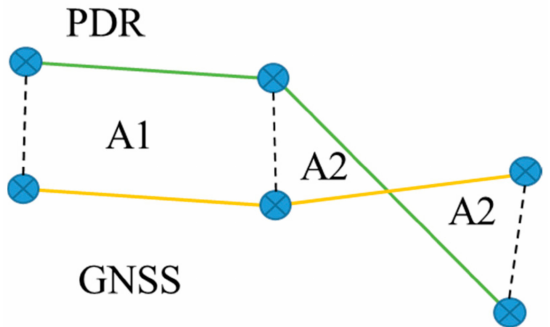
Figure 5. The trapezium area is calculated as defined between the PDR and the GNSS tracks. A threshold of the total area along the track section under investigation classifies the